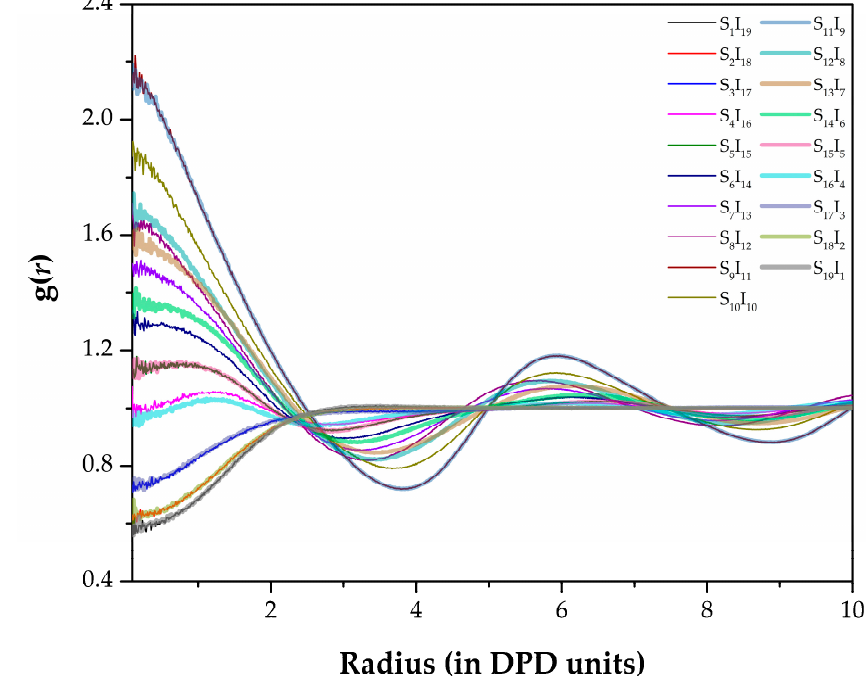
Figure 2. RDFs g( r ) between chain–chain types in different coarse-grained models. r is plotted in the reduced DPD length unit. Some lines are bolded and transparent to ensure that all data can be seen.